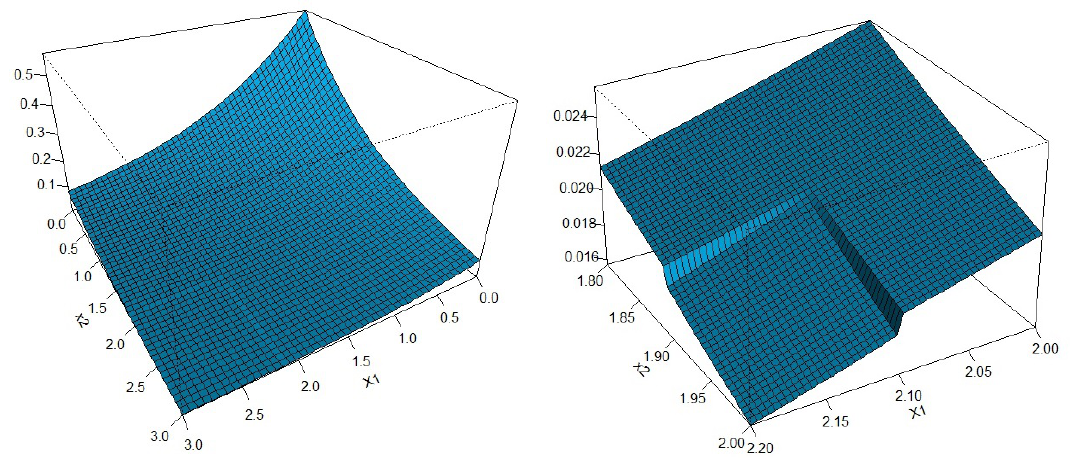
Figure 1. Left : composite Gumbel–Pareto pdf with continuous marginals and continuity at ( θ 1 , θ 2 ) ; Right : zoom of the same pdf (parameters: λ 1 = 0.81, λ 2 = 0.9, β = 0.2, a = 1.0258, θ 1 = 2.1, θ 2 = 1.89).